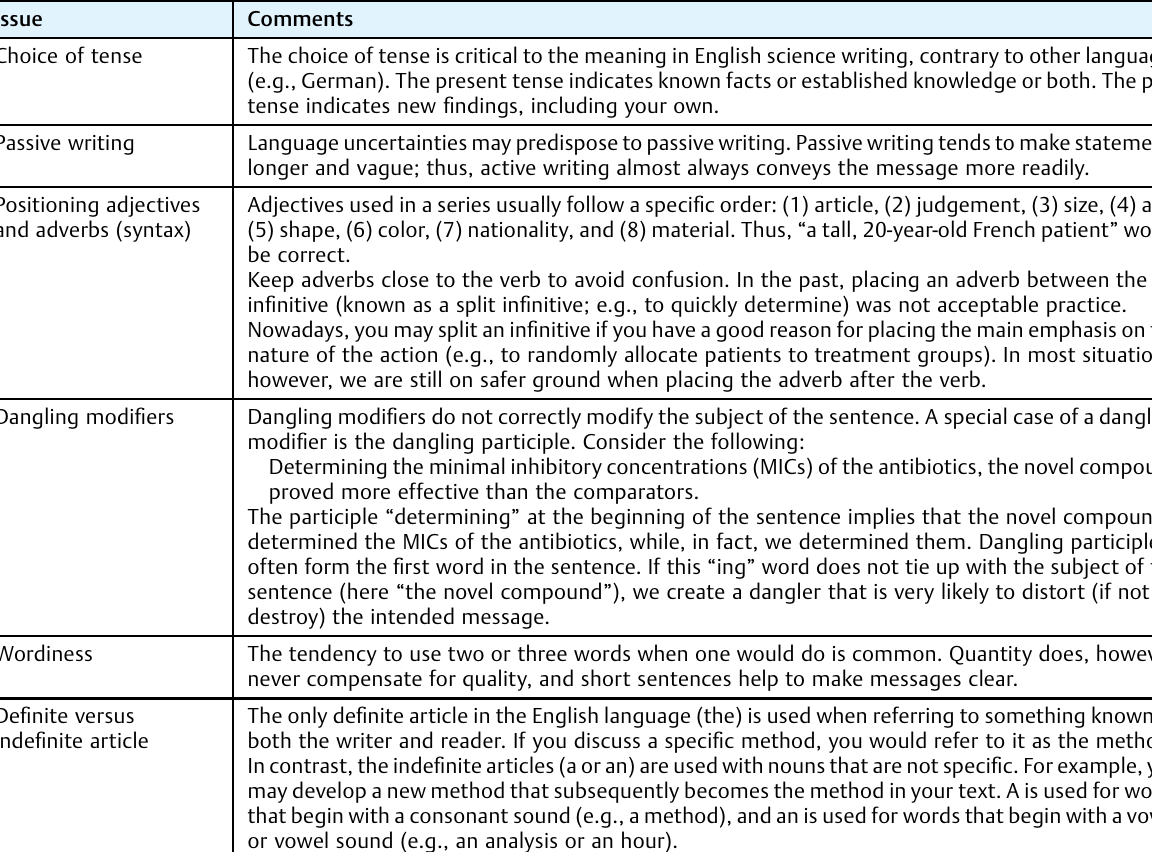
Table 3 The most common issues in science